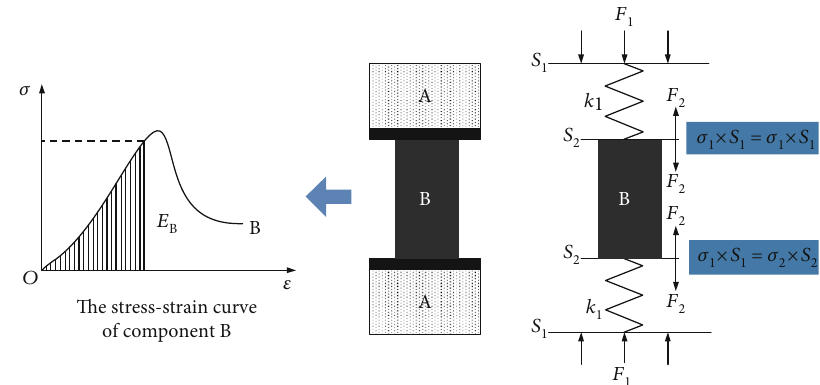
Figure 5: Mechanical analysis of non-same diameter coal-rock combined body model.